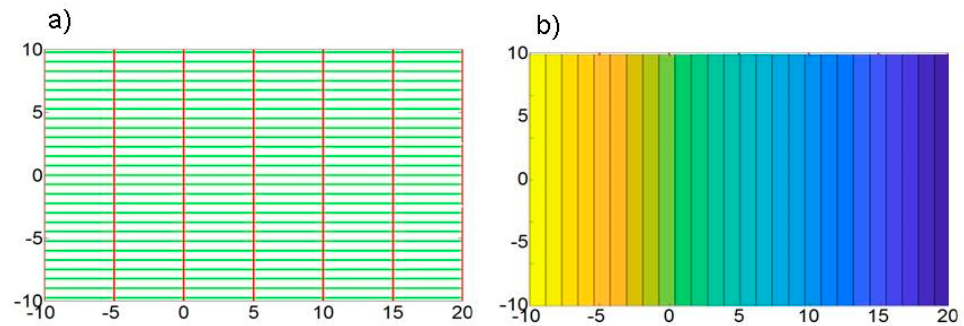
Figure 2. ( a ) Flow model space marked with streamlines (green) and the time-of-flight-contours (red). Flow comes in from the left. ( b ) Isobars for pressure field (warm colors indicate higher pressure) calculated by taking the real part of the complex potential for configuration in ( a ). Algorithms for the model are given in Appendix A. Length units are scaled in µ m (both x-axis and y-axis).